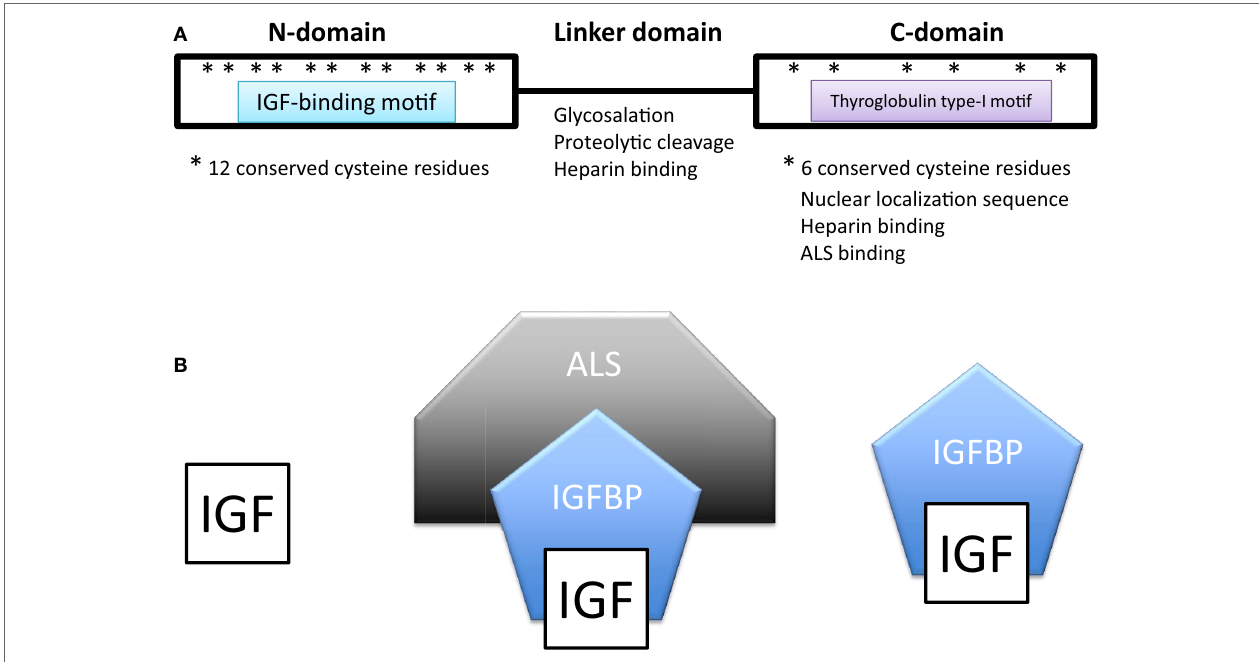
FiGURe 1 | (A) Domain structure of insulin-like growth factor-binding proteins (IGFBPs). IGFBPs contain conserved N- and C-terminal domains and a variable linker domain between them. The N-domain contains an insulin-like growth factor (IGF)-binding motif and the C-domain contains a thyroglobulin type-I repeat. The N-domain usually contains 12 conserved cysteine residues and the C-domain contains 6. (B) In extracellular environments, most IGFs are bound with IGFBPs, either in a binary complex containing one IGF and one IGFBP or a ternary complex consisting of an IGF, IGFBP-3 (or less often IGFBP-5), and a glycoprotein called acid labile subunit